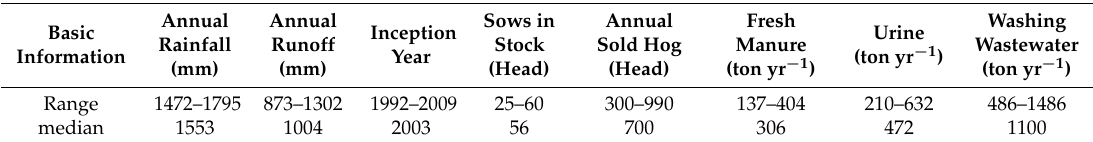
Table 2. Basic information on sample pig farms ( n = 29).